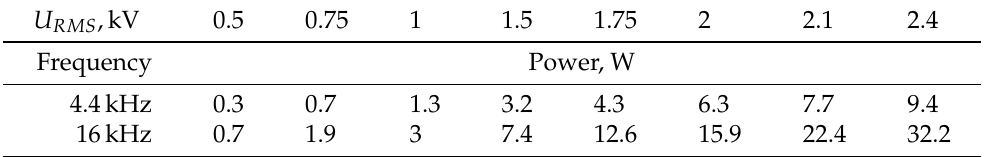
Table 4. Discharge power for various plasma treatment